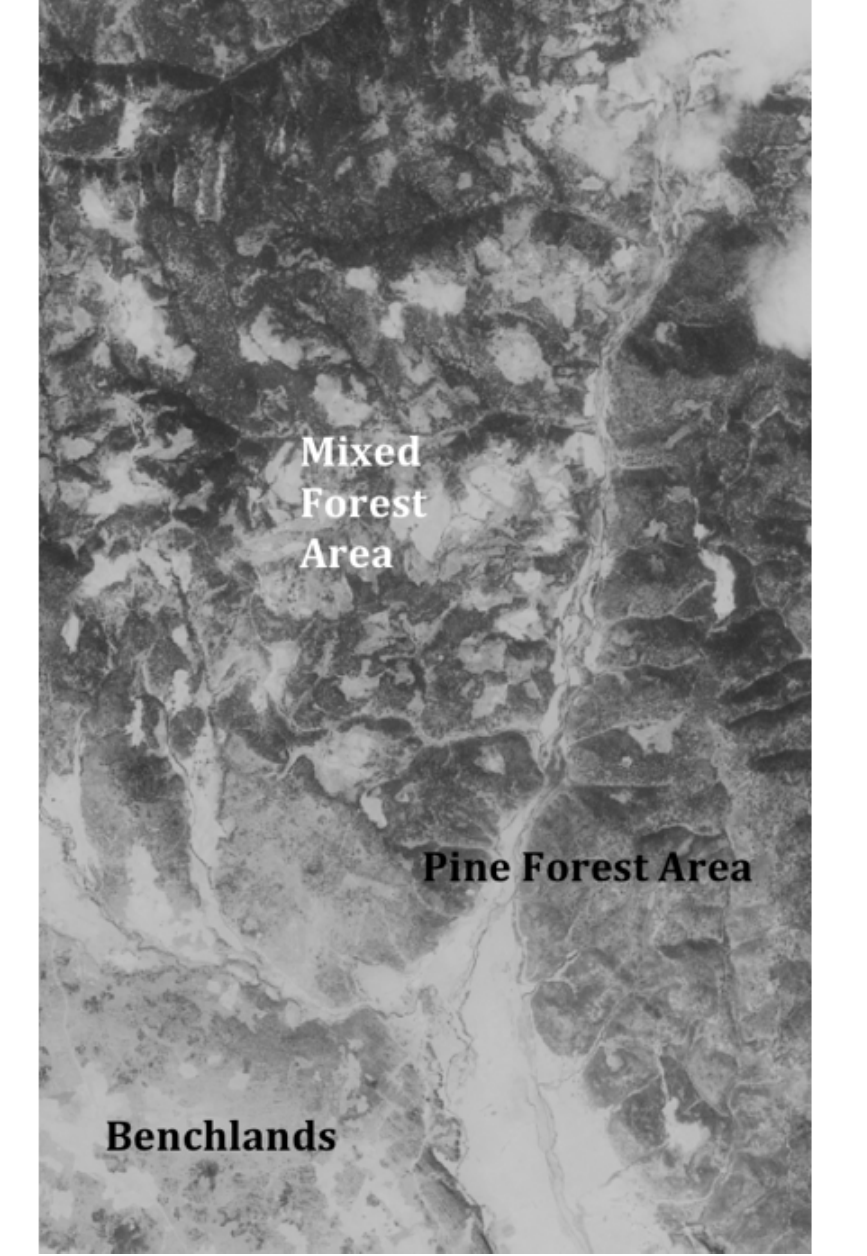
Fig. 9. United States Air Force Corona satellite image of part of the Upper Baiwu watershed in 1968. Note the extensive cutting in the mixed forest area in the western part of the Apiladda watershed, sparse vegetation in the benchlands, and gallery forests in the Apiladda